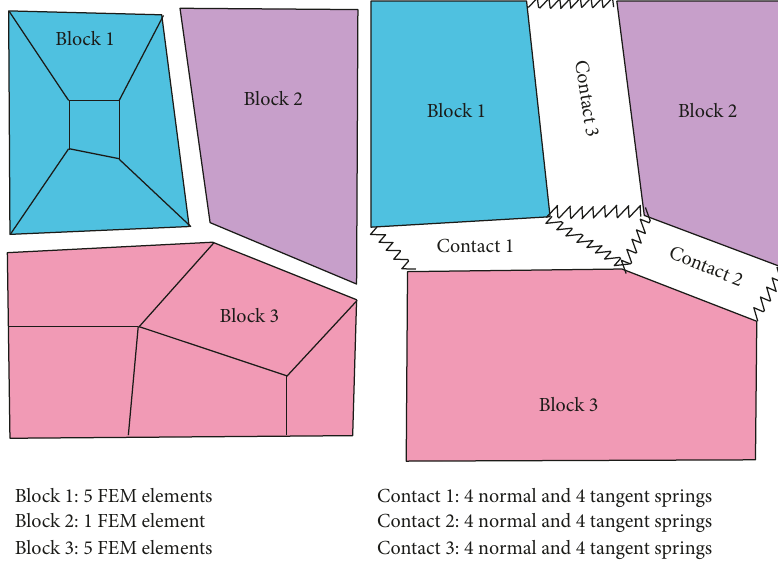
Figure 2: Blocks and interfaces for 8 nodes hexahedron